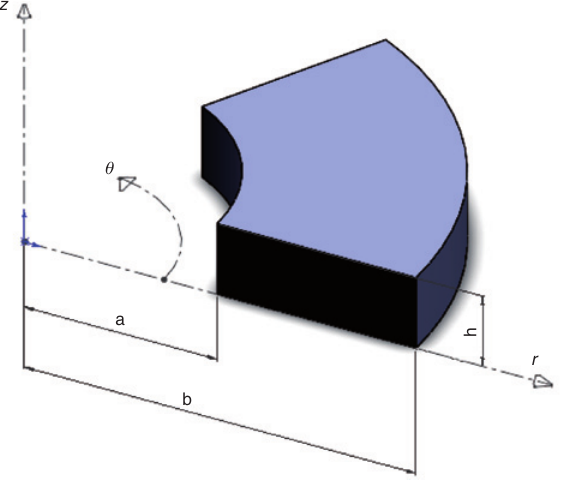
Figure 1 Geometry of an annular sector